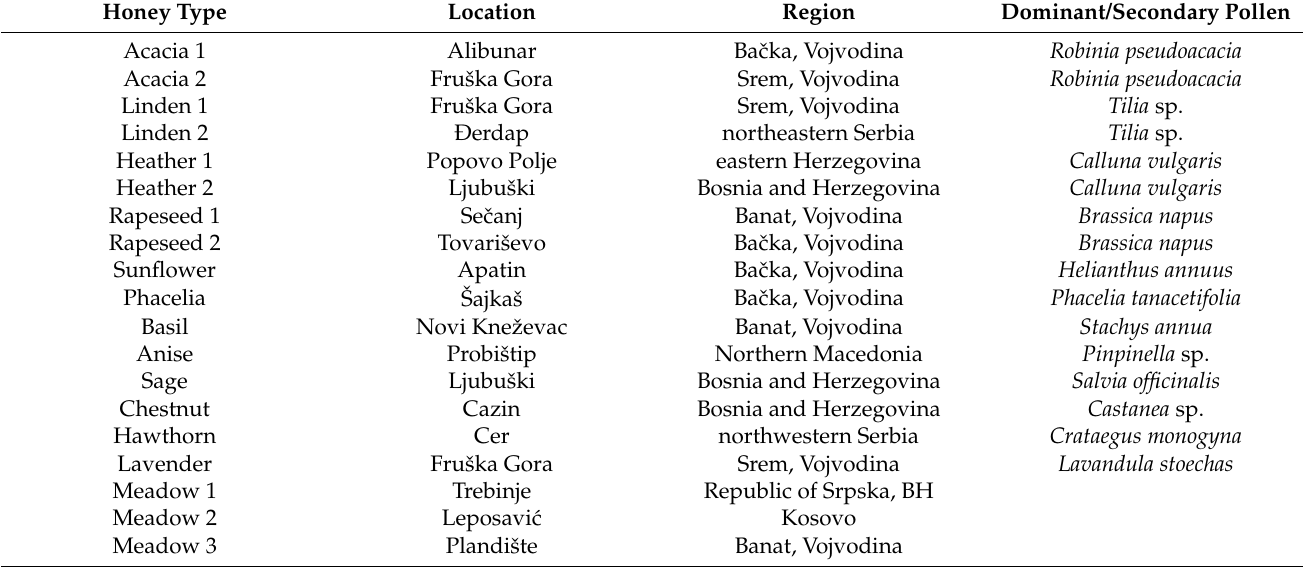
Table 1. Type of honey sample, location, and dominant/secondary